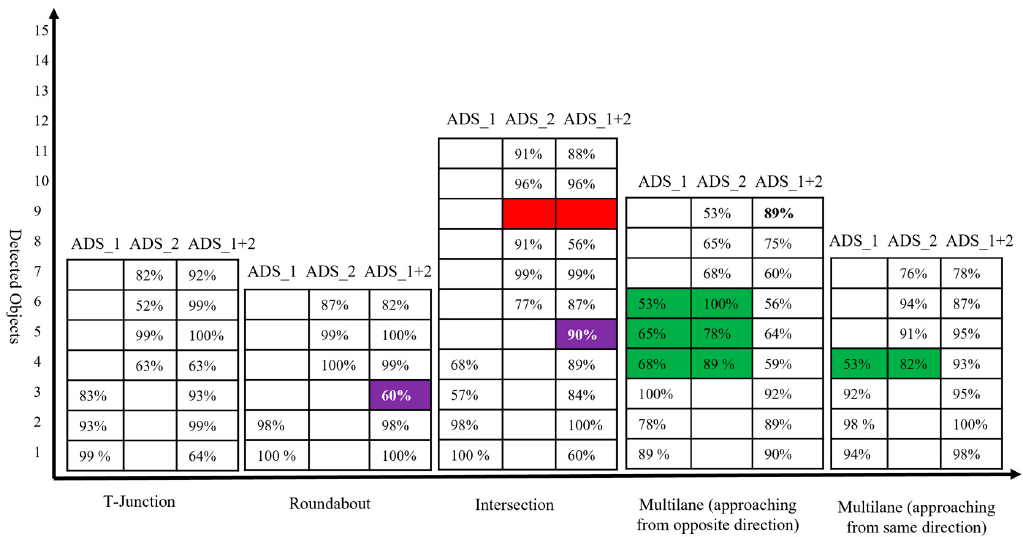
Figure 6. The intuitive detection result of ADS_1, ADS_2, and collaborative perception of ADS_1. The table presents the detection confidence in the percentage of each ADSs, as well as the collaborative perception of ADS_1. Table 1. The detection performance of individual perception systems of ADS_1, ADS_2 vs. collabo- rative perception system.